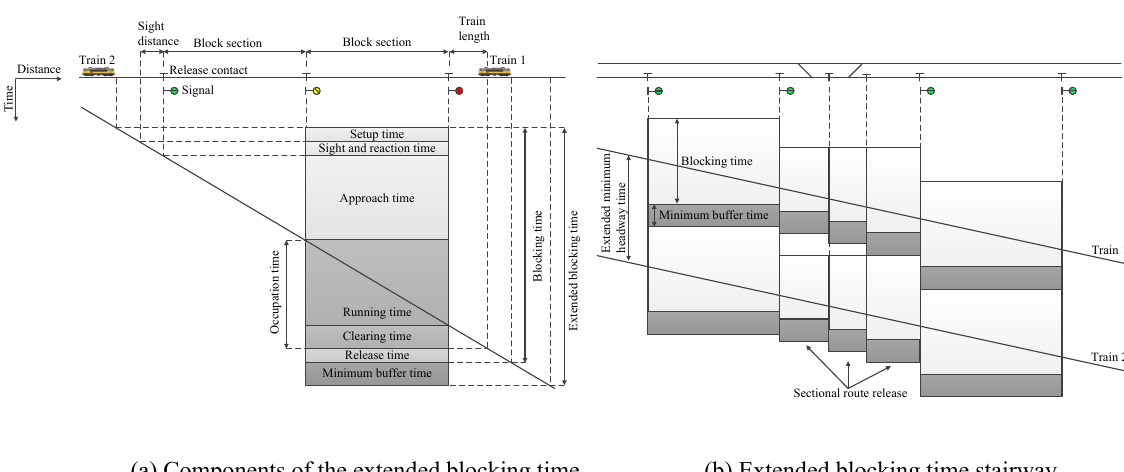
Figure 1: The left plot (a) shows the attributes for the extended blocking time stairway includ- ing the minimum buffer time for a three-aspect signalling system. The right plot (b) indicates a partial blocking time stairway for two successive trains including the (minimum) buffer